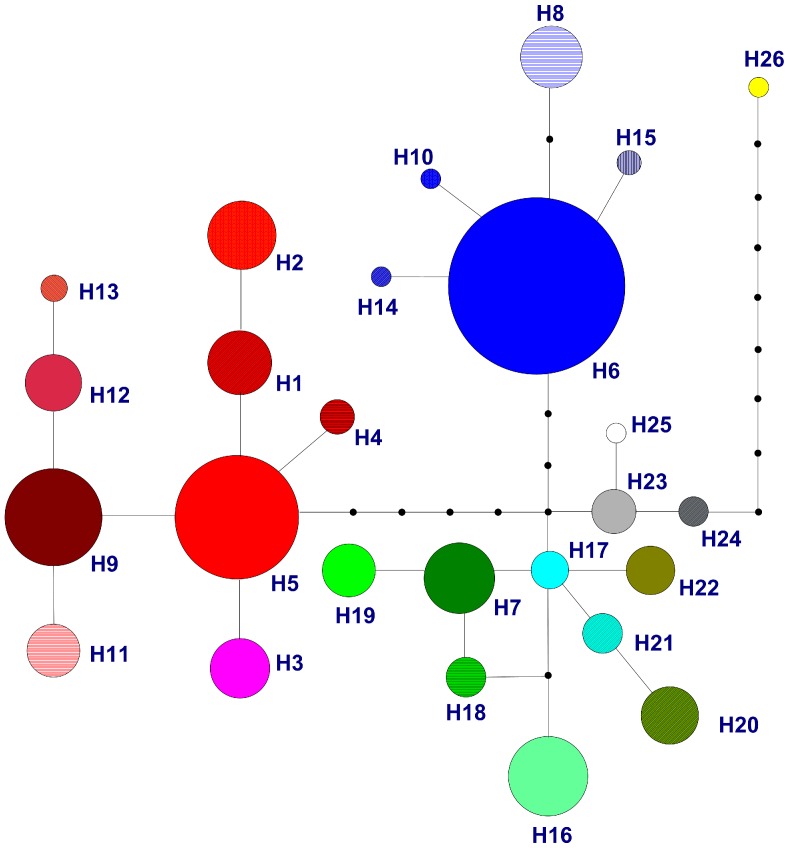
A network of the cpDNA haplotypes constructed by using TCS 1.21.The sizes of the circles in the network are proportional to the observed frequencies of the haplotypes.